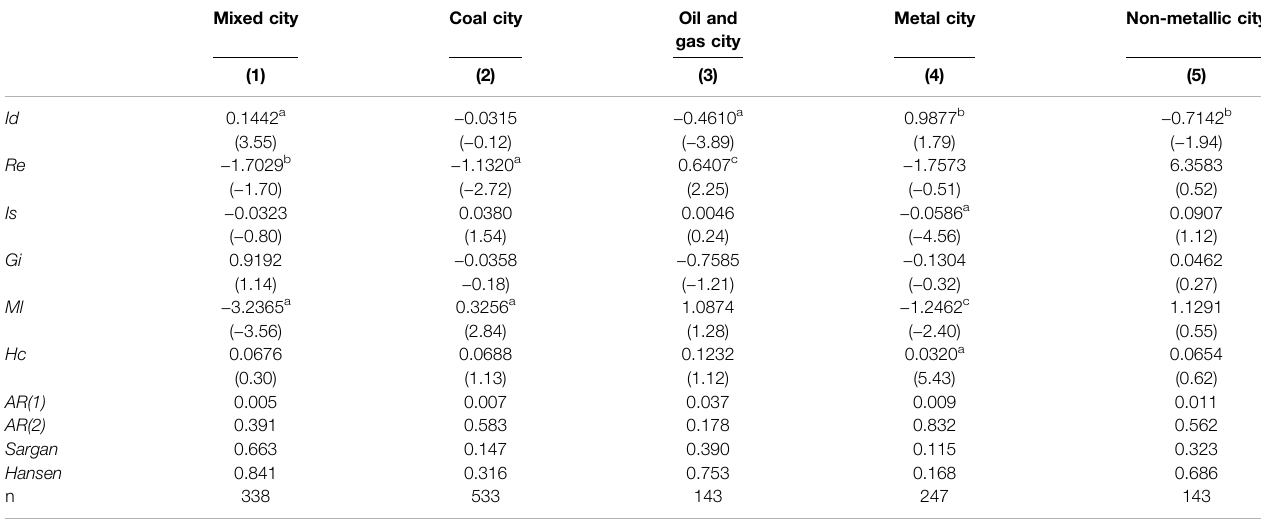
TABLE 8 | Heterogeneity test results: different resource attributes. Mixed city